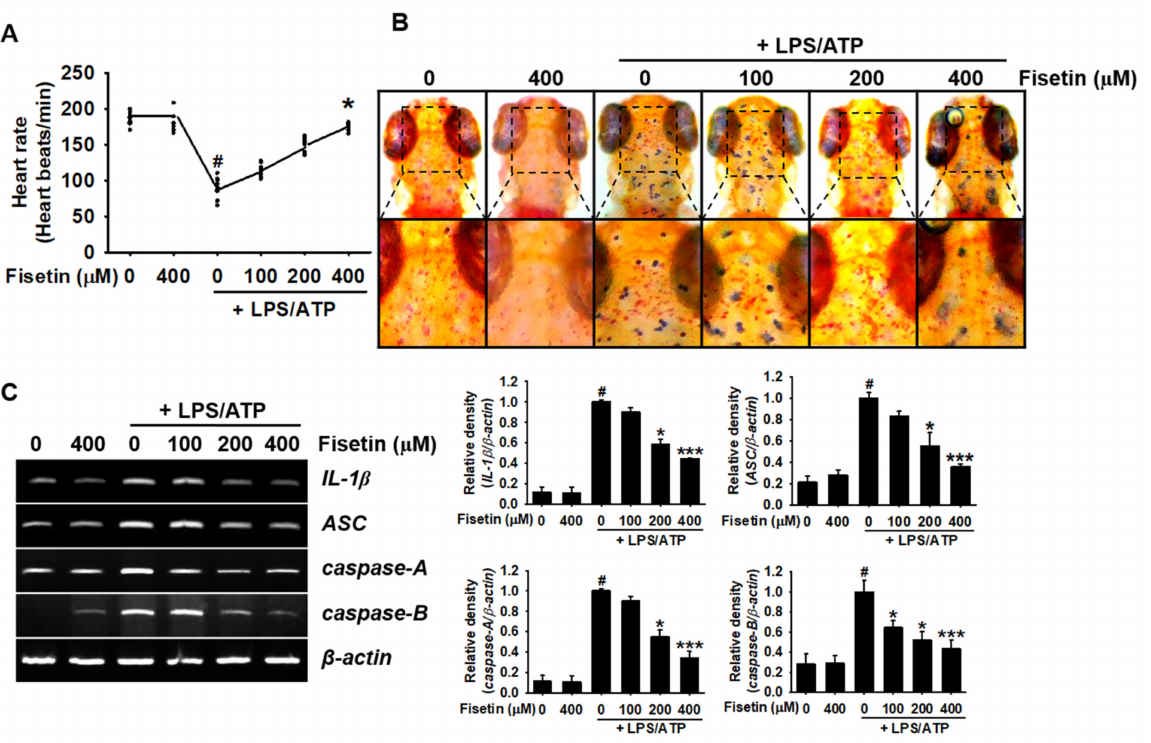
Figure 7. Fisetin inhibits the formation of NLRP3 inflammasome and the expression of IL-1 β in zebrafish larvae. After 3 days of fertilization, zebrafish larvae ( n = 20) were pretreated with the indicated concentrations of fisetin for 2 h prior to stimulation with 5 µ g/mL LPS for 2 h, and subsequent stimulation with 2 mM ATP (LPS/ATP). ( A ) After 24 h, heart rates were measured for 2 min and expressed as beats/min. ( B ) Neutral red staining for detecting the distribution of macrophages after 24 h of treatment with LPS/ATP. ( C ) Total RNA was extracted after 18 h of treatment with LPS/ATP, and the expression of IL-1 β , ASC , caspase-A , and caspase-B was determined using RT-PCR. β -Actin was used as a loading control. Relative densities were calculated using ImageJ software. The results indicate the mean ± standard error median (SEM), and is representative of the results obtained from three independent experiments. # p < 0.05 vs. untreated zebrafish larvae; *** p < 0.001 and * p < 0.05 vs. LPS/ATP-treated zebrafish